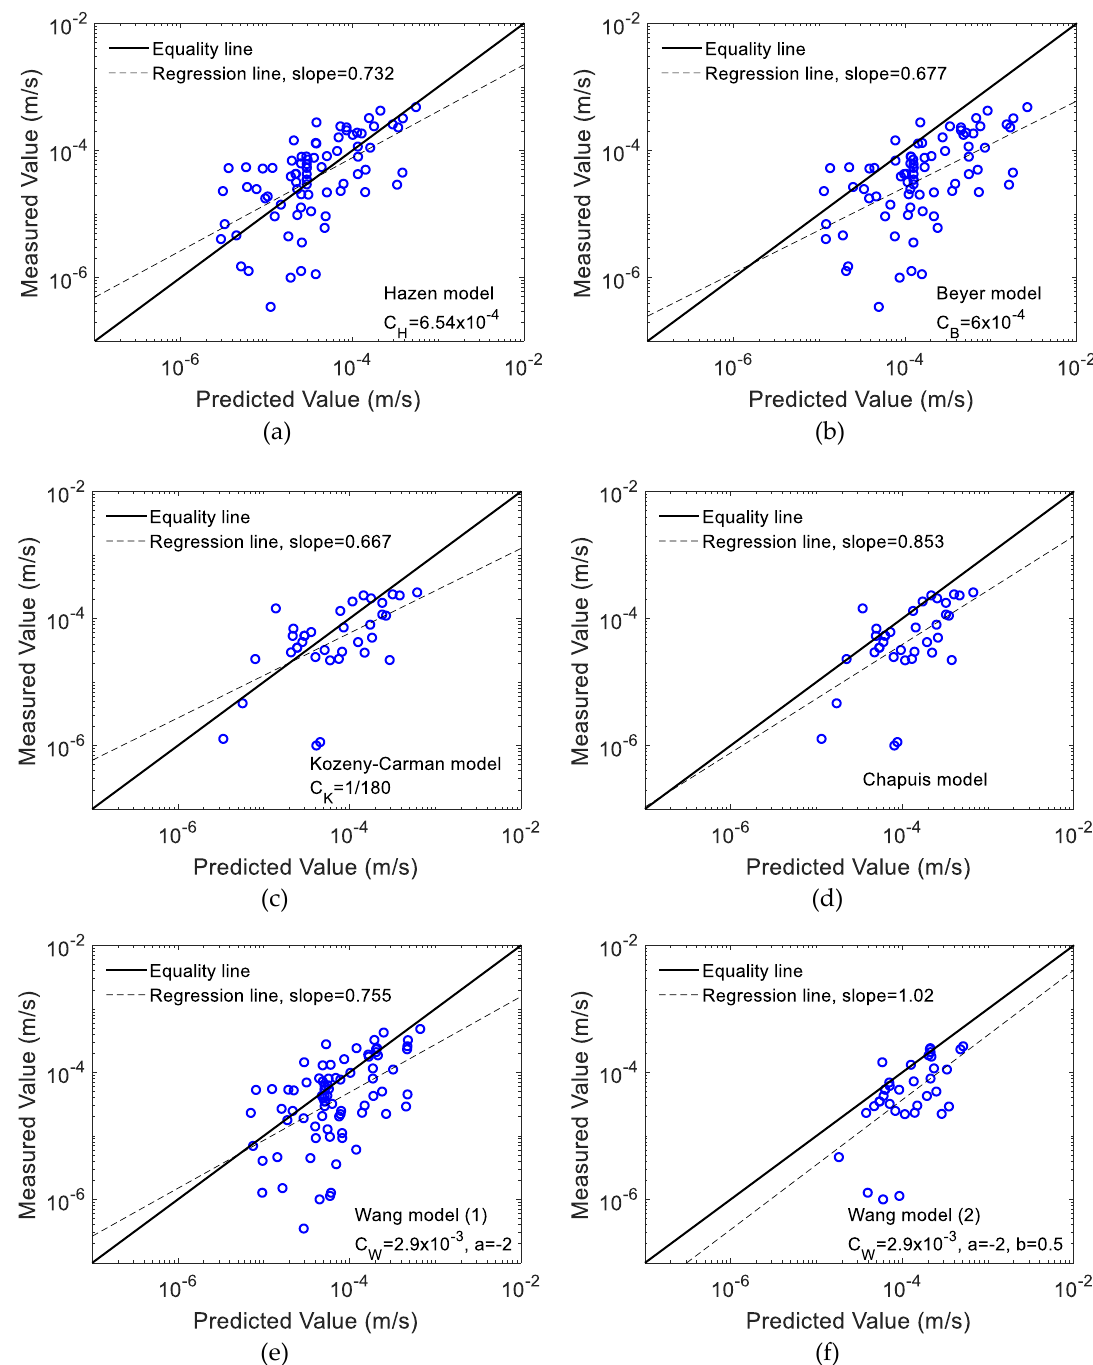
Figure 3. Prediction of different models on sandy soils with 𝑑 10 > 0.02mm and 𝐶 𝑢 < 20 from the UNSODA database. ( a ) Hazen model; ( b ) Beyer model; ( c ) Kozeny – Carman model; ( d ) Chapuis model; ( e ) model of Equation (6); ( f ) model of Equation (8).